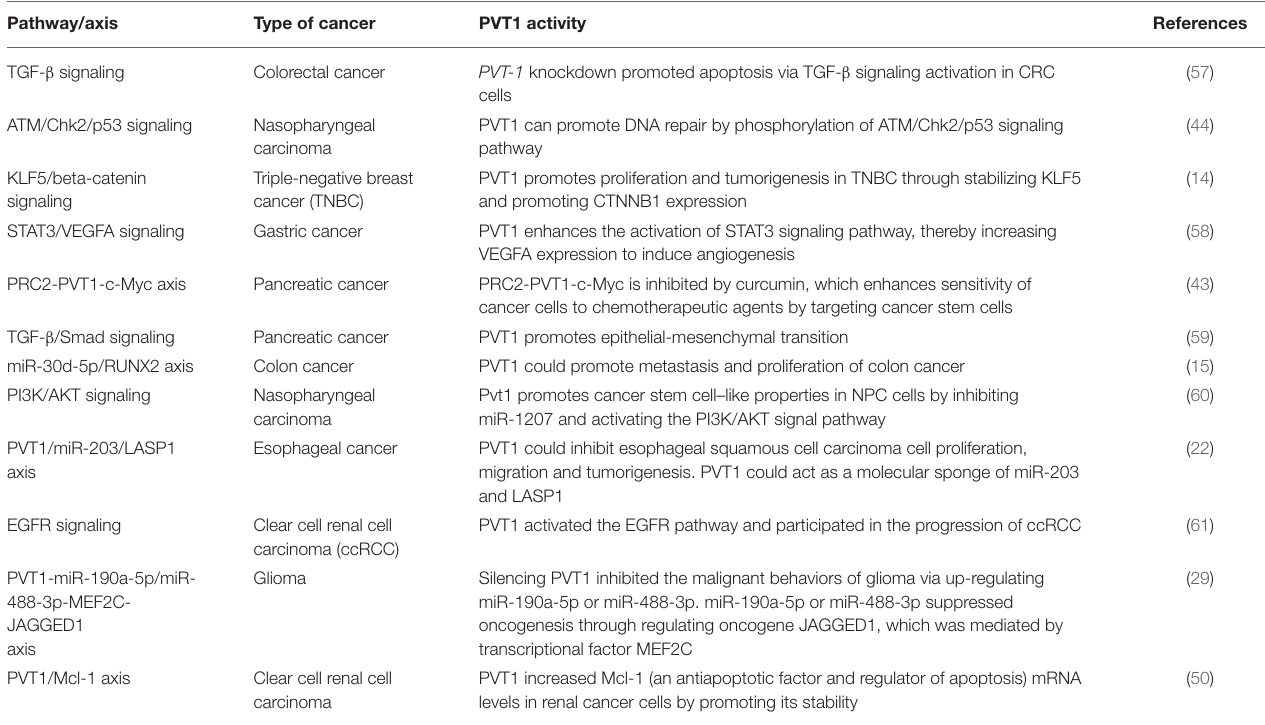
TABLE 1 | Signaling pathways linked to PVT1 in